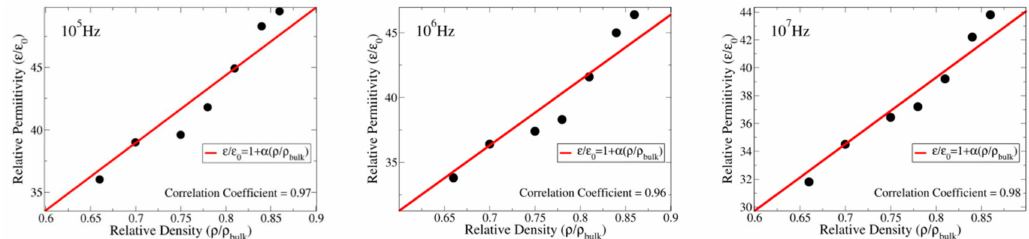
Figure 5. Dielectric permittivity as a function of the relative density measured at 10 5 , 10 6 and 10 7 Hz. The obtained correlation coe ffi cients, 0.97, 0.96 and 0.98 indicate a strong correlation between